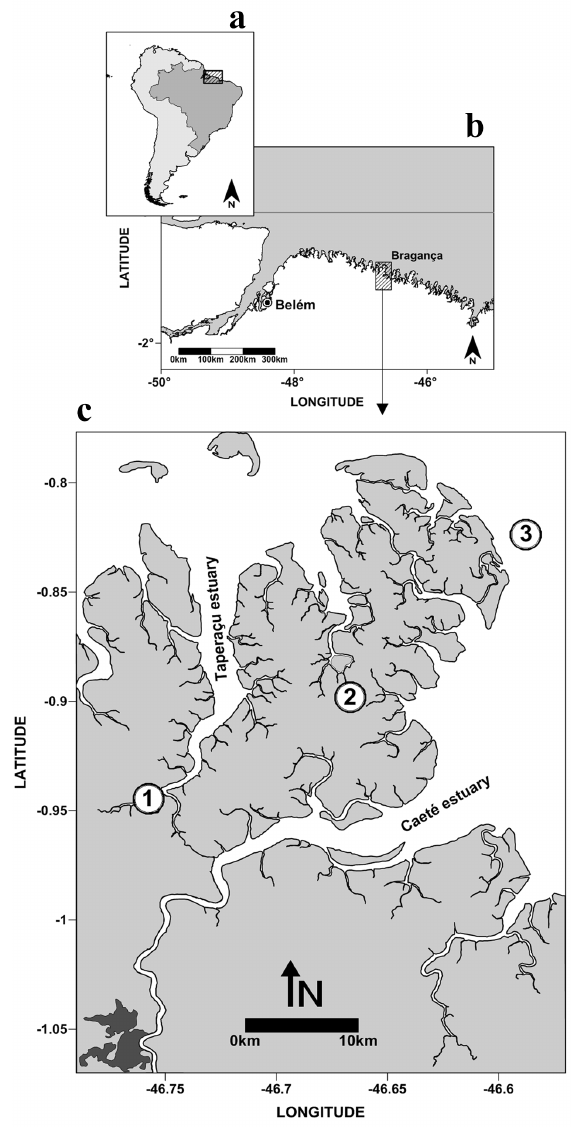
Figure 1 - Study area: South America ( a ), Northern Brazil coast ( b ), and positions of the sampling stations in Pará coastal zone - 1, Taperaçu estuary; 2, salt lagoon; 3, continental shelf ( c